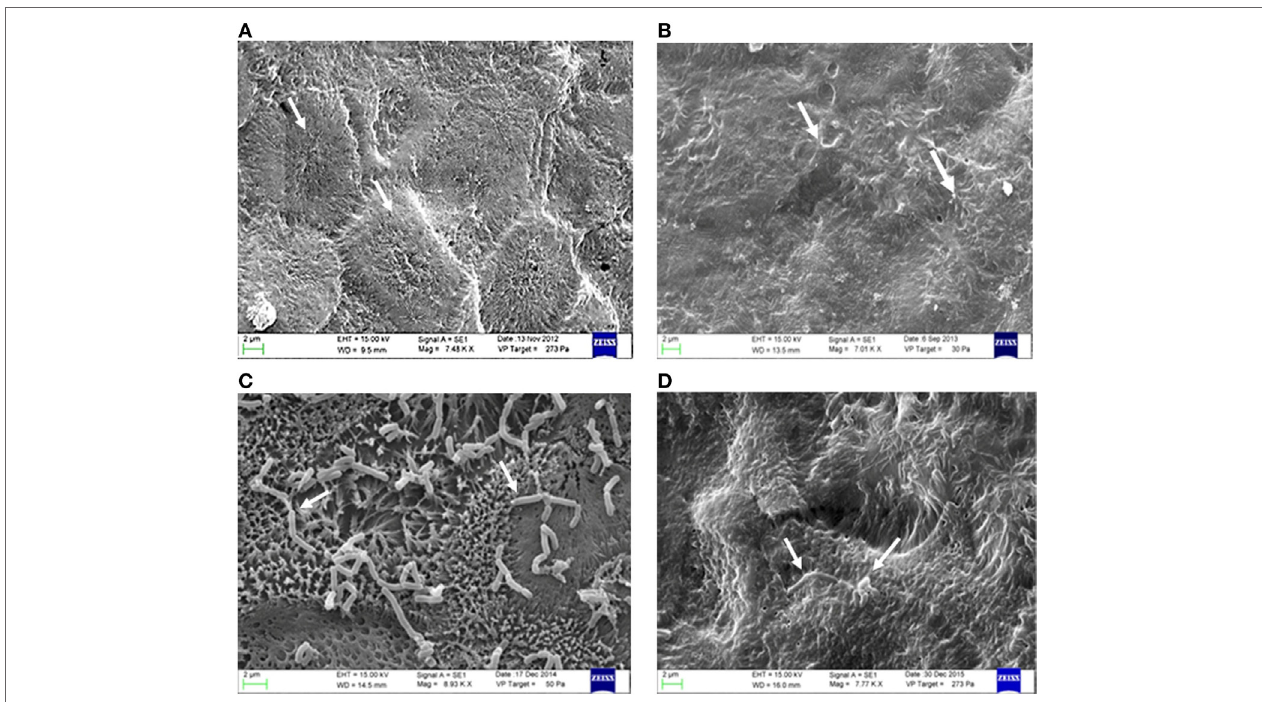
FigUre 6 | Morphological and ultrastructural analysis (electron microscopy) of epithelial co-culture Tc7 and Lactobacillus casei Shirota (LS). The (a) show the morphological state of the monolayer epithelium consisting of the human colon carcinoma cell line (Caco-2)/Tc7 culture cell line in physiological equilibrium (control). The (B) show the differentiated Caco-2/TC7 cells grown on transwell filters and treated with 20 mg/mL of 2,2 ′ -Azobis (2-amidinopropane) dihydrochloride (AAPH) for 2.5 h at 37°C. The arrows indicate that the cell margins are not evident, suggesting a possible cellular membrane damage. Panel (c) shows the monolayer co-culture of the Caco-2/tc7 pretreated with 1 mL of DMEM containing 5 × 10 7 /CFU of LS for 1.5 h in the apical compartment. Panel (D) shows morphology of the Caco-2/TC7 cells pretreated with 1 mL of DMEM containing 5 × 10 7 /CFU of LS for 1.5 h in the apical compartment. After pretreatment with LS, cells were treated with 20 mg/mL of AAPH in order to induce oxidative stress for other 2.5 h at 37°C. The arrows indicate a strong discrasia of the LS cells which has various forms and different size. The figure is representative of at least three experiments conducted in